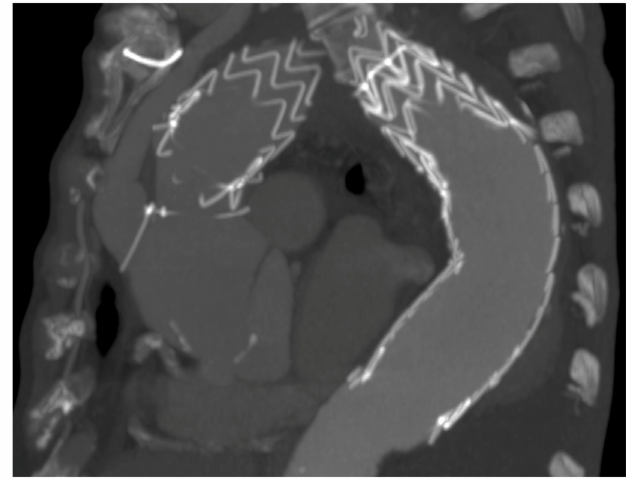
Figure 5. Example of retrograde dissection in a type I